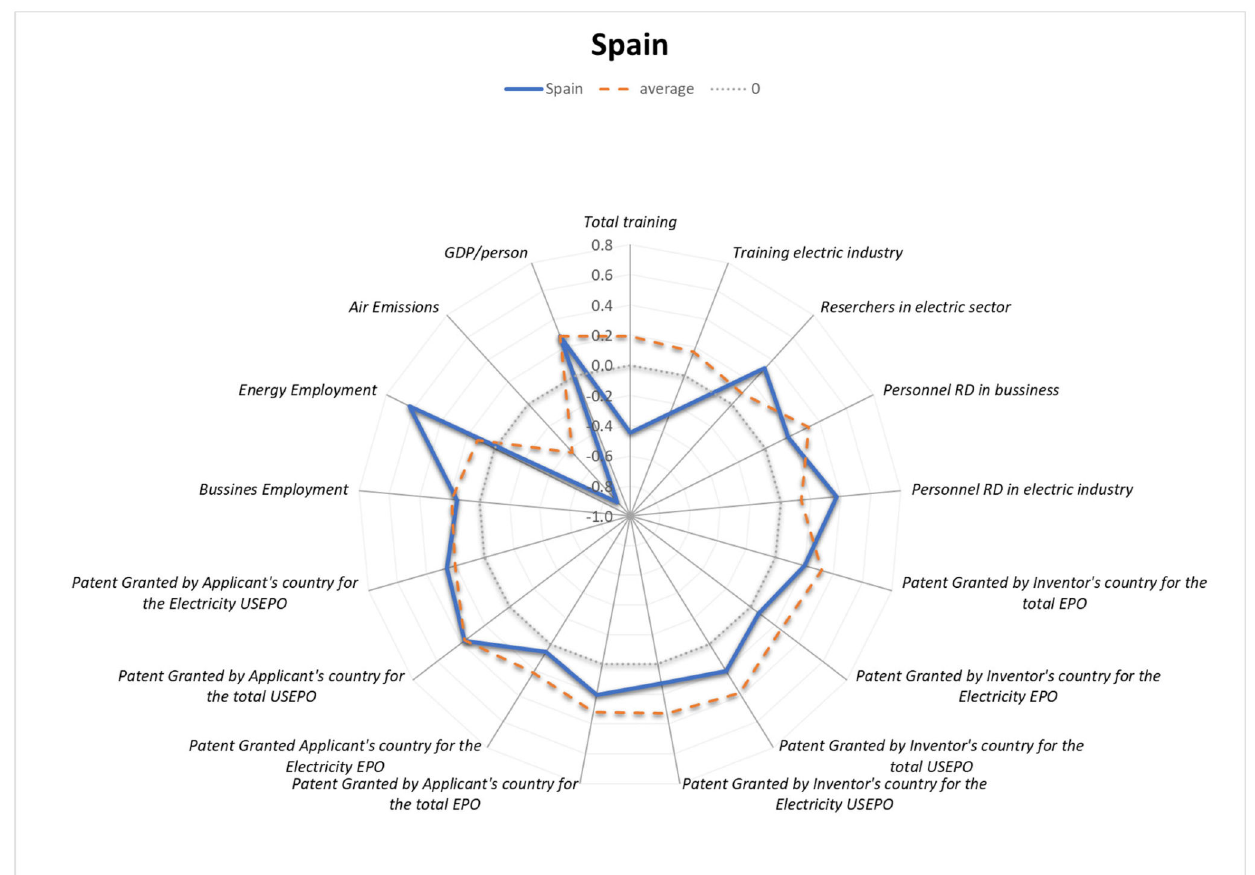
Figure 34. Synergy and trade-off occurrence—ES. Source: Authors’